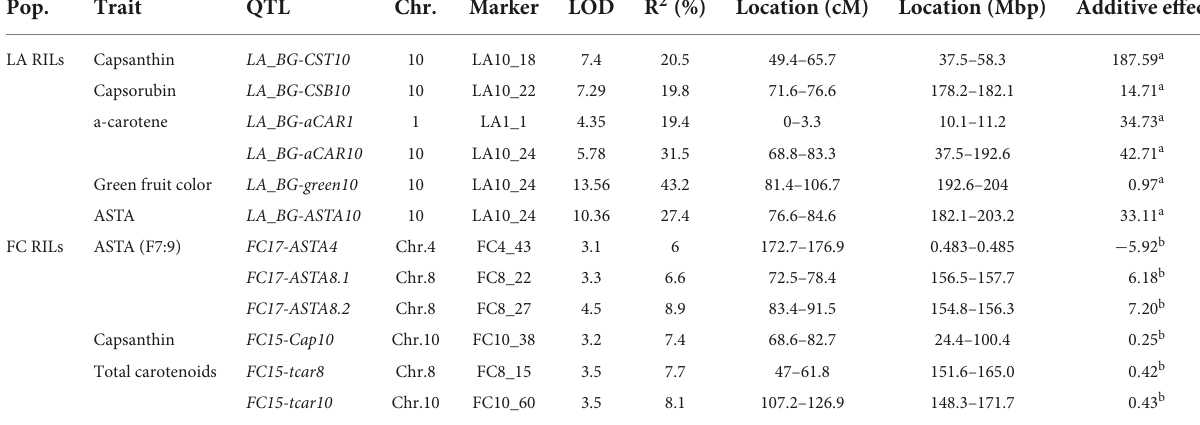
TABLE 2 Quantitative trait loci (QTLs) for carotenoid contents and green intensity of LA recombinant inbred lines (RILs).